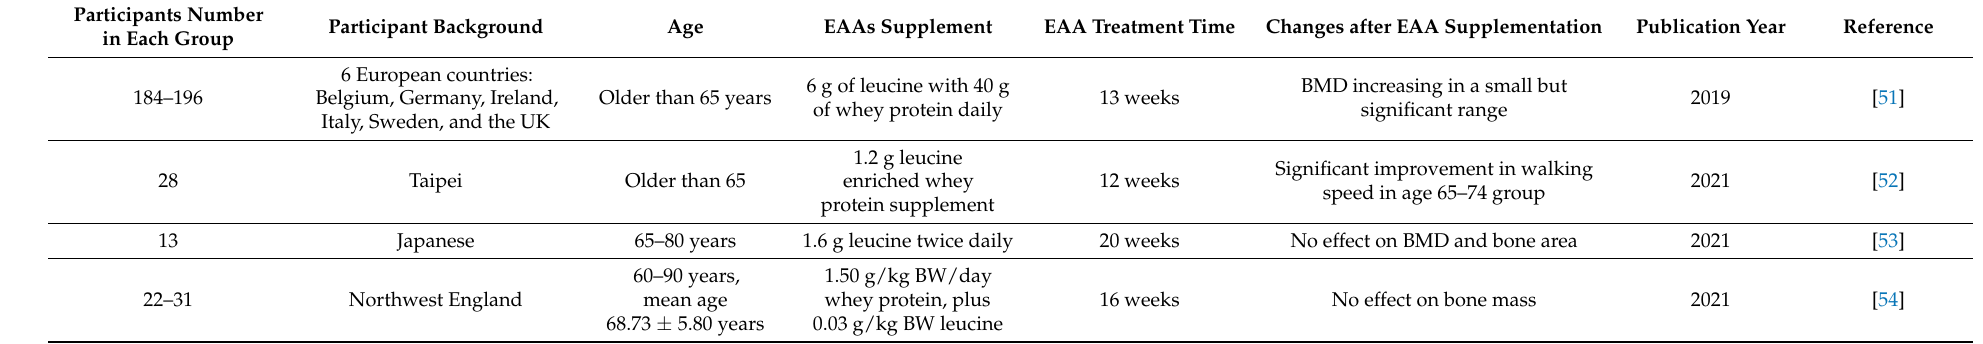
Table 2. Impact of EAA supplementation in aging